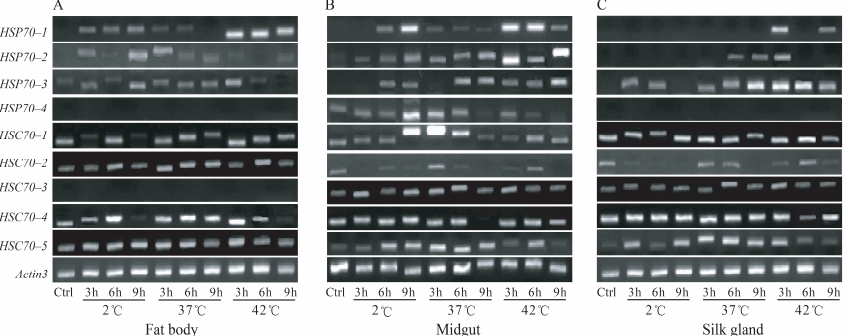
Figure 4. The transcriptional responses of HSP70/HSC70 genes after cold and thermal exposures. ( A – C ) Gene responses in the fat body, midgut, and silk gland, respectively. The larvae on day 3 of the fifth instar were exposed to 2 °C for 3 h, 6 h, and 9 h, and heat shock at 37 °C and 42 °C for 3 h, 6 h, and 9 h, respectively. All the treatment followed by 2 h recovery at 25 °C. Ctrl: control.